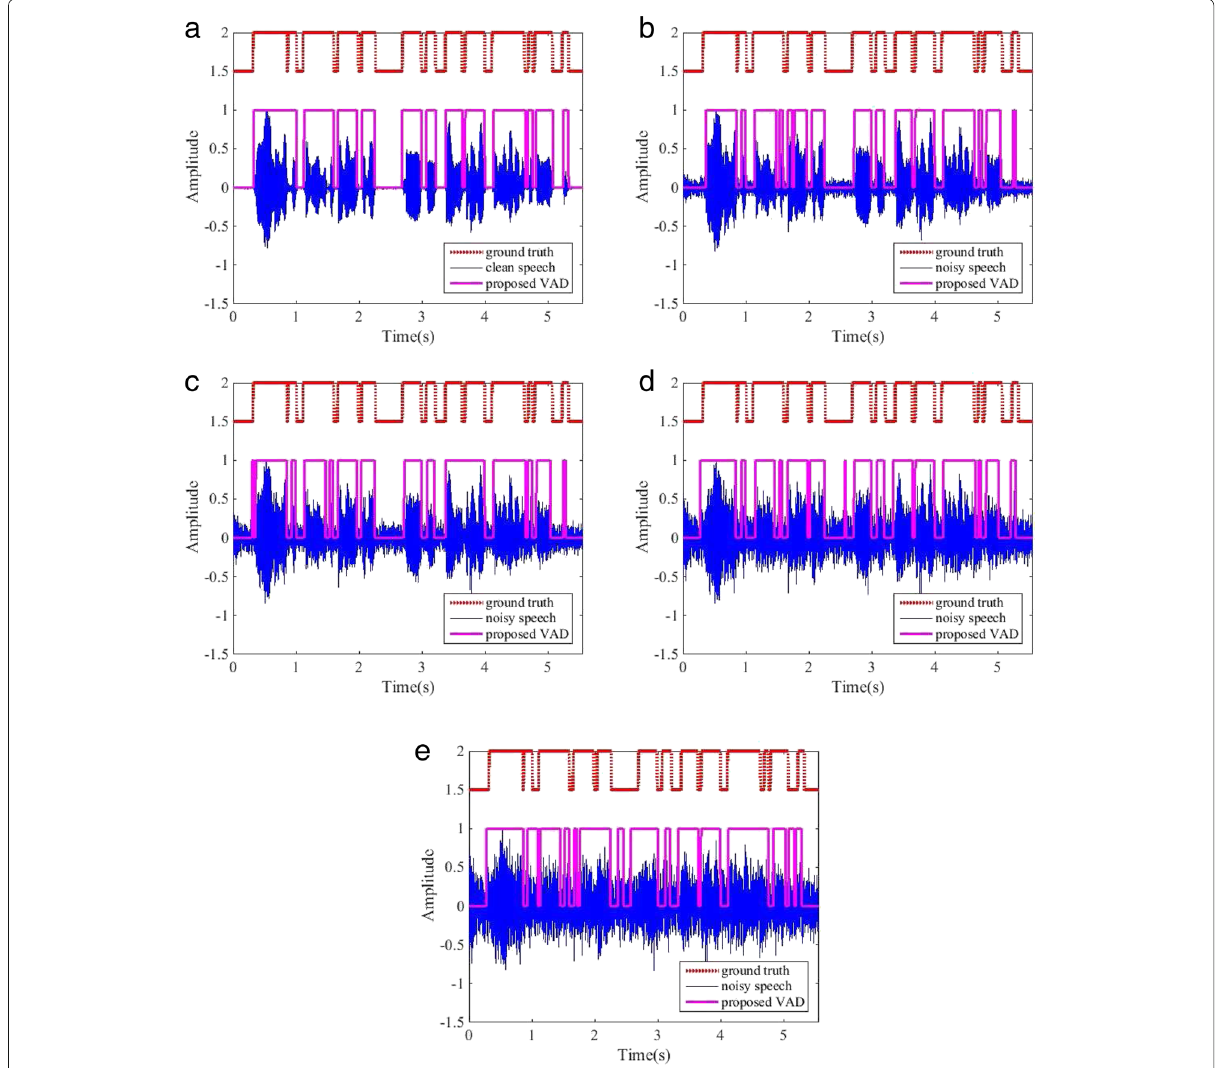
Fig. 7 Representative results of the proposed VAD method. a Clean speech. b Factory noise, SNR = 10 dB. c Factory noise, SNR = 5 dB. d Factory noise, SNR = 0 dB. e Factory noise, SNR = − 5